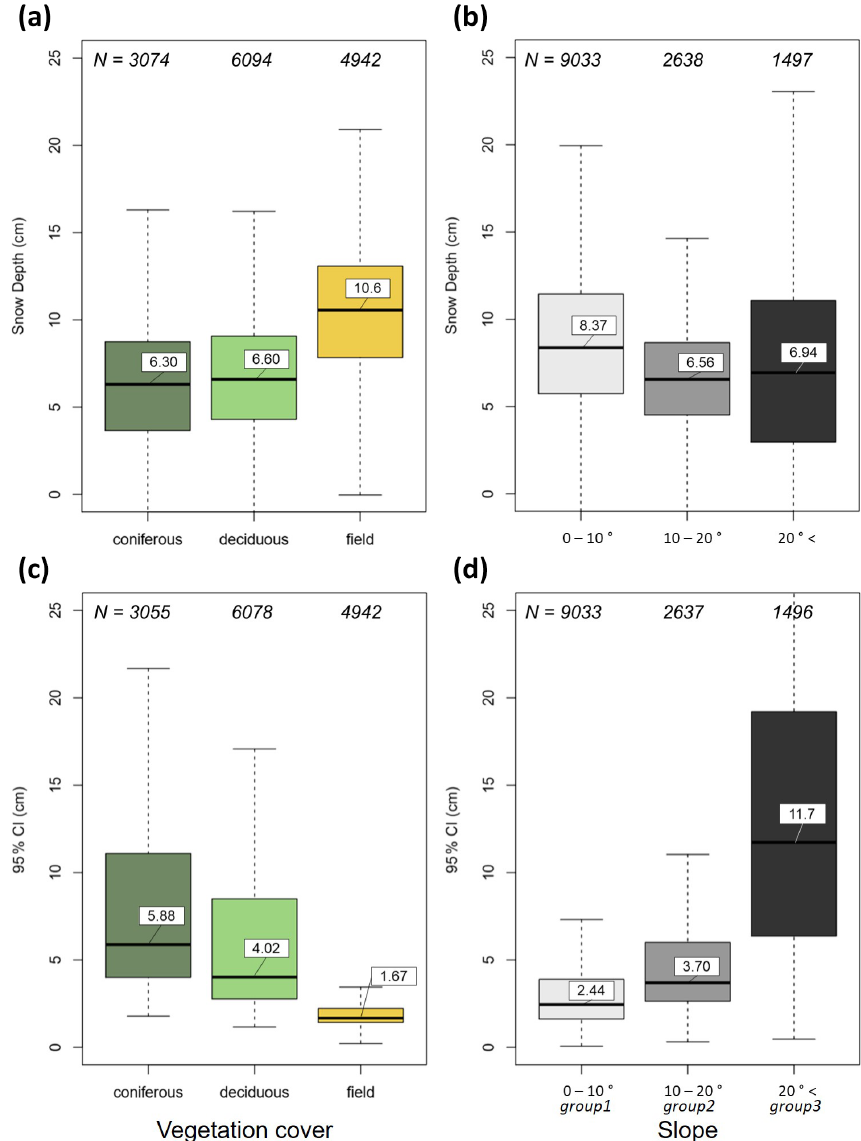
Figure 6. Snow depths (a, b) and their one-sided confidence intervals (c, d) from the random sample points of the field and forest at Thompson Farm, Durham, NH, on 23 January 2019 from the individual cells for 1m 2 cells by vegetation cover (a, c) and slope group (b, d) . Boxplots show the lower quartile, median, upper quartile, and whiskers with the median value noted. Because of missing values in the raster images, not all random points extracted values and resulted in different numbers of sample points for vegetation cover